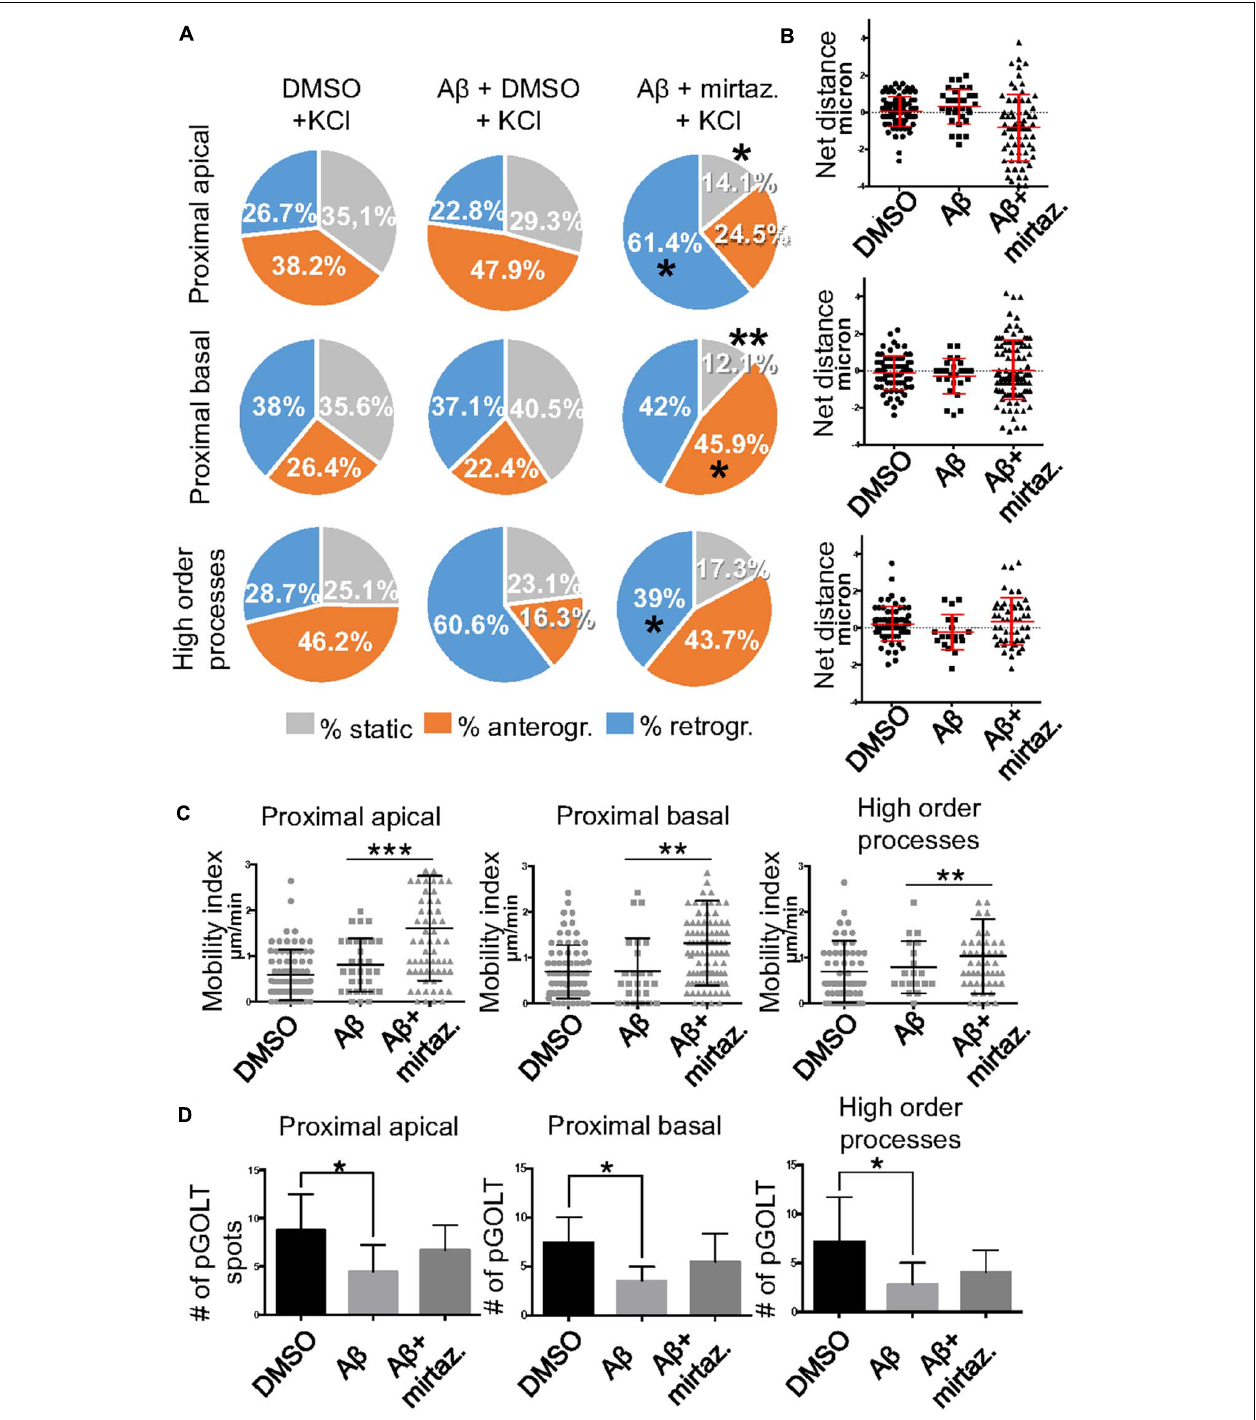
FIGURE 5 | Effects of A β and mirtazapine on pGOLT vesicle trafficking in 50 mM KCl-stimulated cultures. (A) Pie charts representation of the average percentage of anterograde, retrograde, and static pGOLT spots after KCl stimulation (50 mM, 5 min). Data were obtained from 4 to 5 segments in proximal apical, proximal basal, and higher order processes. DMSO: n = 8; A β + DMSO: n = 7; A β + mirtazapine: n = 10. (B) Scatter plot representation of net distance of pGOLT spots in KCl conditions in proximal apical, proximal basal, and higher order processes after 4 h of treatments. (C) Mobility index calculated as the absolute net distance traveled by pGOLT spots in apical segments, basal segments, and higher order segments. DMSO: n = 8, p = 0.0004; A β + DMSO: n = 7, p = 0.0025; A β + mirtazapine: n = 10, p = 0.0173. (D) Average of the number of pGOLT spots in the different segments. DMSO: n = 8; A β + DMSO: n = 7; A β + mirtazapine: n = 10. Following D’Agostino-Pearson’s normality test, we performed a one-way ANOVA test or Kruskal Wallis test. * p ≤ 0.05; ** p ≤ 0.01; *** p ≤ 0.001.